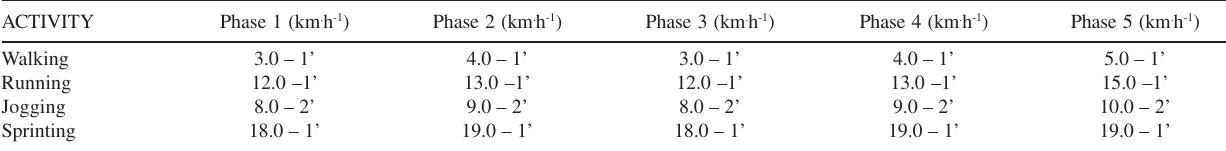
Table 1 – Design of the intermittent tolerance exercise protocol used by the soccer players. ACTIVITY